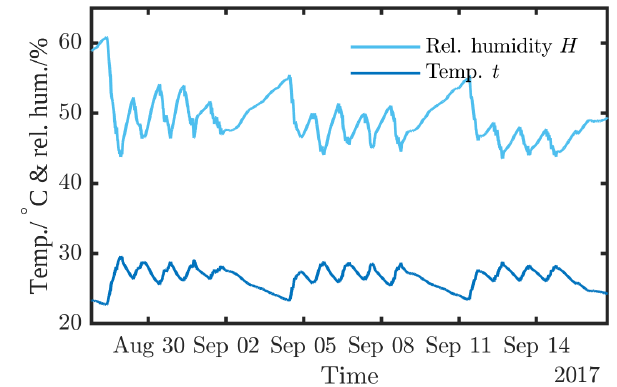
Figure 9. Temperature and humidity in the TTS during the torque calibration of the WTTB.